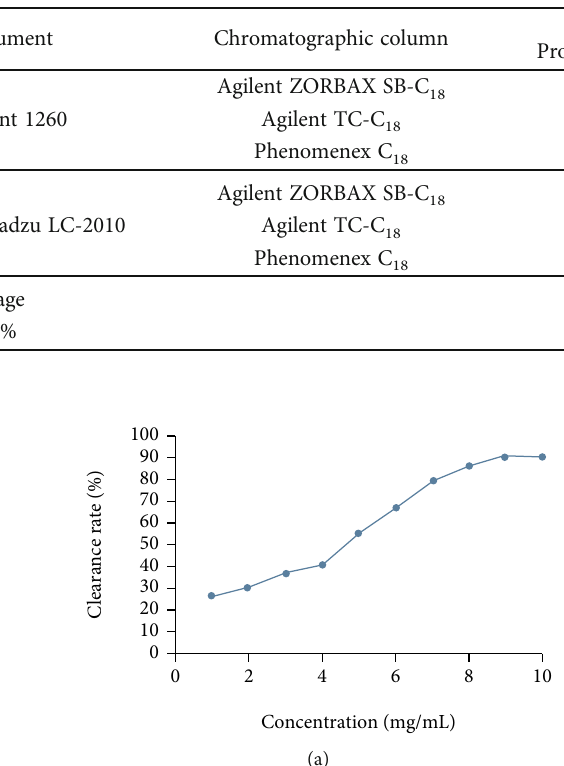
Table 8: Relative retention values of various constituents.